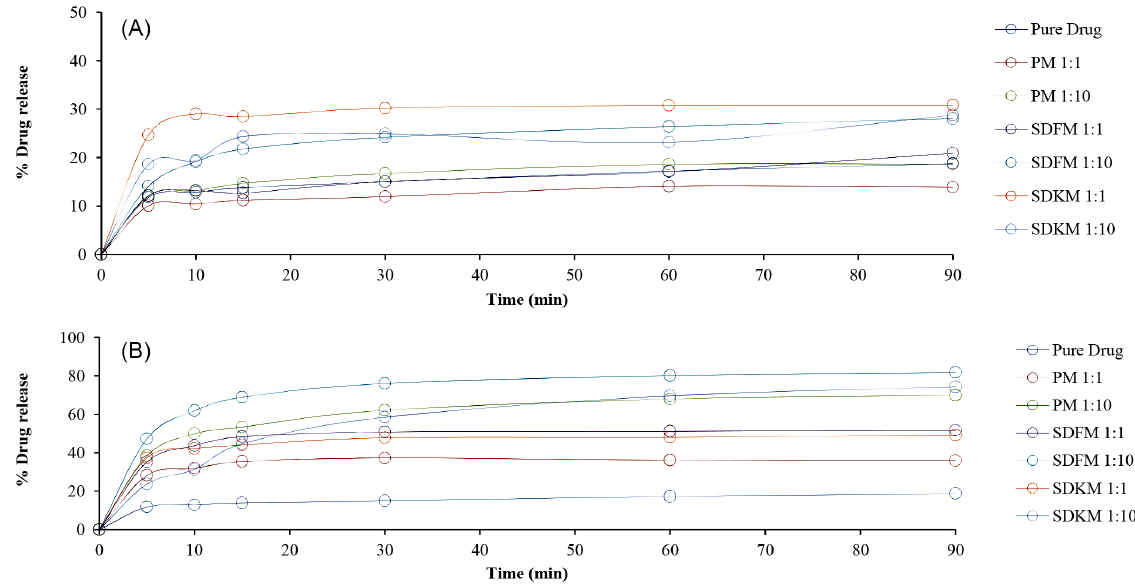
FIGURE 5 - Drug release profiles of pure AMH, physical mixture and solid dispersions obtained from fusion and kneading methods using acetate buffer pH 4.5 as dissolution medium at 37 ºC ± 0.5 ºC and carrier PEG 4000 (A) and carrier PEG 6000